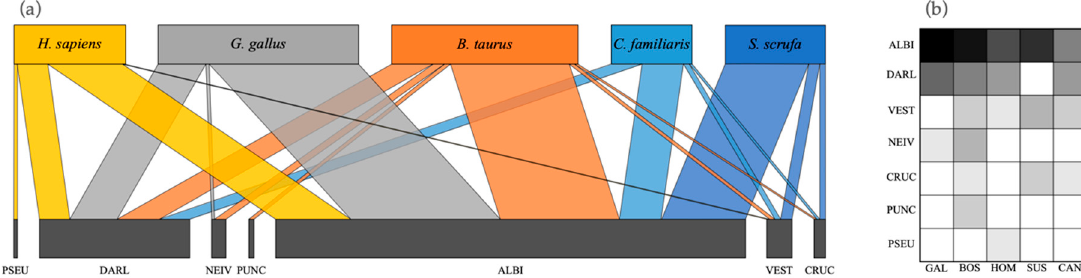
Figure 2. Proportion of blood meal sources by anopheline species.